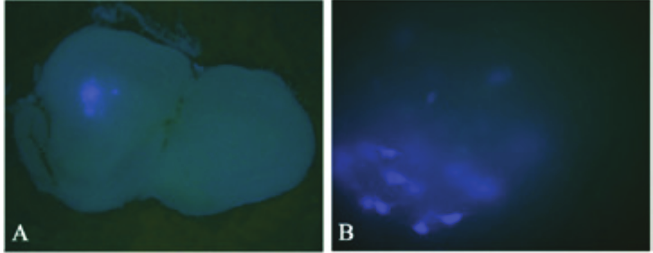
FIGURE 7 - TB positive cells (A: 40x; B: